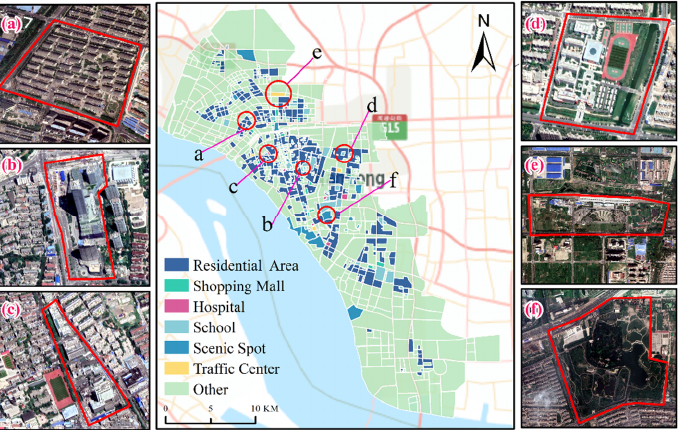
Figure 3. Identification of attributes of UFAs. ( a ) Residential area. ( b ) Shopping mall. ( c ) Hospital. ( d ) School. ( e ) Traffic center. ( f ) Scenic spot. UFAs refer to the urban functional